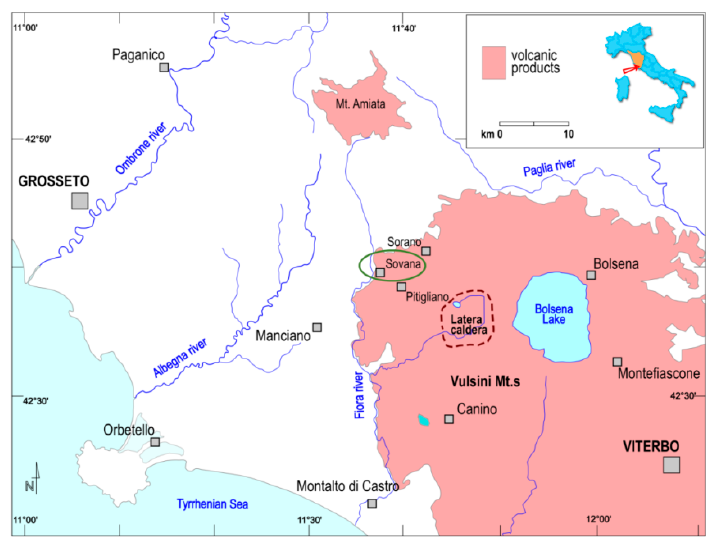
Figure 1. Map of the necropolis (modified after